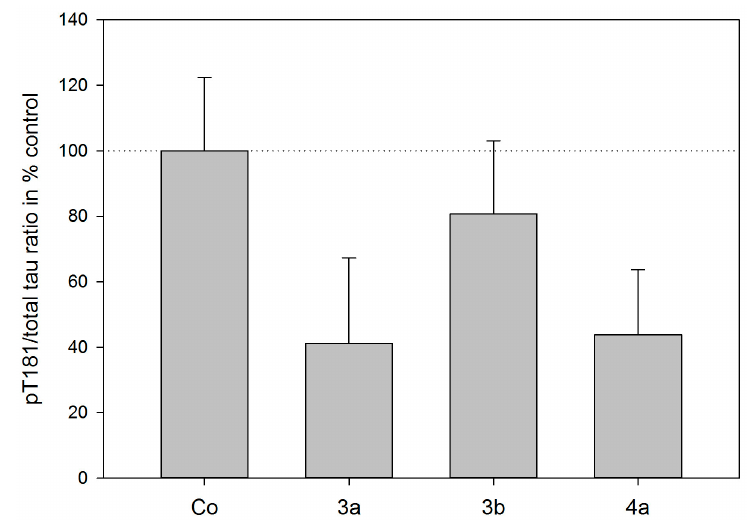
Figure 1. Quantification of threonine 231 und serine 235 tau phosphorylation after 24 h inhibitor treatment at 8 µM concentration of 2N4R-tau transfected COS-7 cells by Western blot analysis. Phospho-dependent immunoreactivity was normalized to total tau immunoreactivity and depicted as mean ± SD.